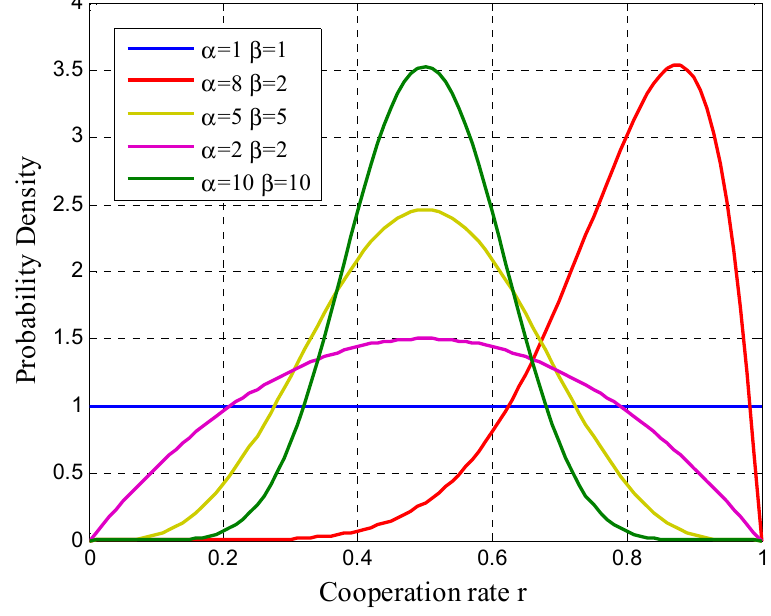
ff erent α and β